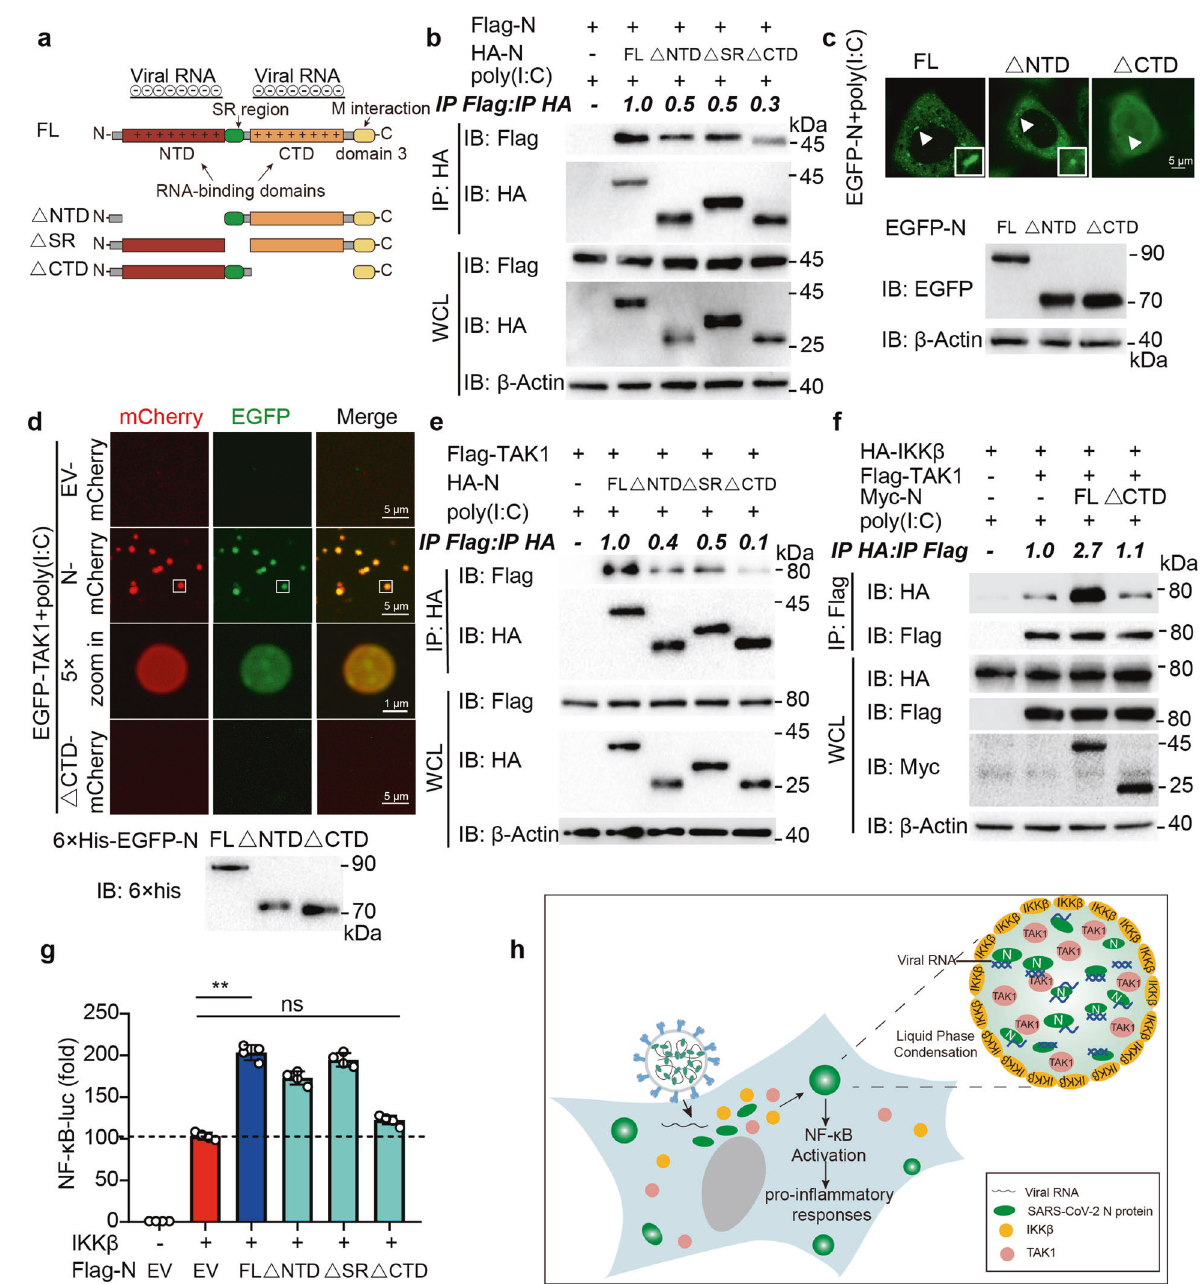
Fig. 5 CTD domain of SARS-CoV-2 N protein CTD domain is critical for its LLPS and NF- κ B regulatory capability. a Domain organization of SARS-CoV-2 N protein and its domain deletion mutants. b HEK293T cells were transfected Flag-N full-length (FL) along with HA-empty vector (EV), HA-N FL, △ NTD, △ SR, and △ CTD. Whole-cell lysates were subjected to immunoprecipitation with anti-HA beads and immunoblot analysis was performed with indicated antibodies. The ratio of the gray value between IP-Flag and IP-HA was determined. c Representative images of live-cell confocal microscopy (up) of HeLa cells expressing EGFP-N FL, △ NTD, and △ CTD. Immunoblot analysis (down) were performed on the cell lysates with indicated antibodies. d Representative images showing TAK1 was distributed into N protein-poly(I:C) droplets in vitro. 10 µM mCherry-N protein or mCherry-N protein- △ CTD, 5 µM EGFP-TAK1 were mixed with 10 ng/mL poly(I:C) and incubated at 37 °C for 10 min. Confocal 5× zoom-in of the area highlighted above was re-photographed. Scale bars, 5 μ m. e Lysates of HEK293T cells transfected Flag-TAK1 and HA-EV, HA-N FL, △ NTD, △ SR, and △ CTD, together with 1 µg/mL poly(I:C) for 6 h, were performed immunoprecipitation with anti-HA beads and immunoblotted by indicated antibodies. The ratio of the gray value between IP-Flag and IP-HA was determined. f Lysates of HEK293T cells transfected with HA-IKK β and Flag-EV, Flag-TAK1, Myc-EV, Myc-N FL, and △ CTD, followed by 1 µg/ mL poly(I:C) treatment for 6 h were performed immunoprecipitation with anti-Flag beads and immunoblotted by indicated antibodies. The ratio of the gray value between IP-HA and IP-Flag was determined. g HEK293T cells were transiently transfected with NF- κ B luciferase reporter, TK-luk, and IKK β , together with Flag-EV, Flag-N FL, △ NTD, △ SR, and △ CTD. Lysates were collected at 36 h post-transfection and luciferase activities were tested. h Schematic representation of SRAS-CoV-2 N protein regulating NF- κ B signaling pathway by recruiting TAK1 and IKK β through liquid – liquid phase separation. Data in ( g ) are expressed as mean ± SEM of at least three independent experiments. ** p < 0.01, ns, not signi fi cant (two-tailed Student ’ s t -test). For ( b – f ), similar results are obtained for three independent biological experiments